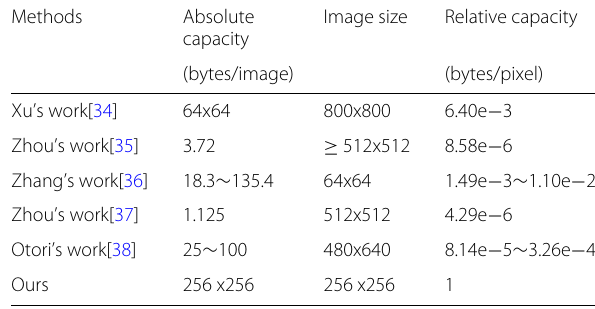
Table 1 Comparisons of hiding